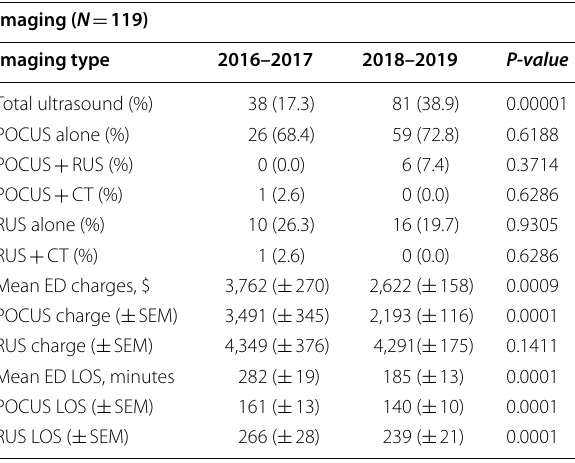
Table 2 Clinical experience. Description of imaging types, ED length of stay, and charges for corresponding